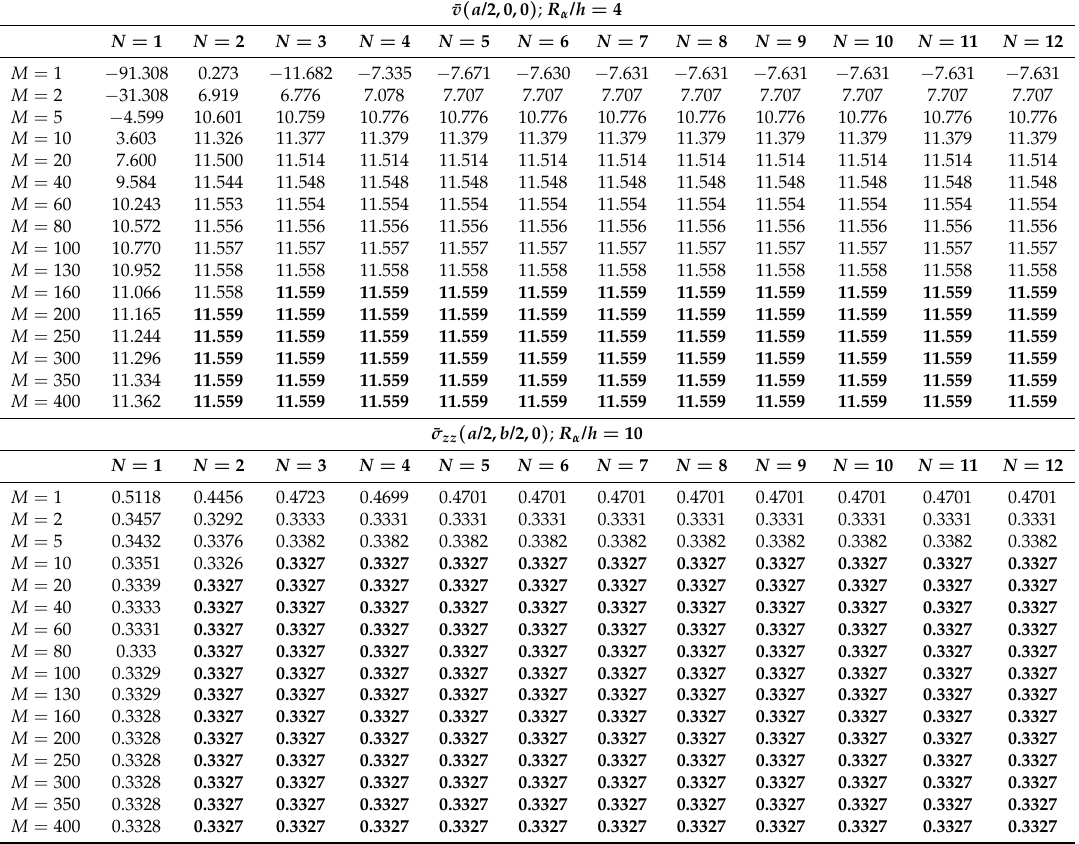
Table 2. Case 2, one-layered FGM ( κ = 1) cylinder. Displacement ¯ v for thickness ratio R α / h = 4 and stress ¯ σ zz for thickness ratio R α / h = 10, both evaluated in the middle of the thickness and given as dimensionless values. One physical layer ( N L = 1) divided into M global mathematical layers. 3D reference solution in Brischetto [23]. Digits given in bold are the correct